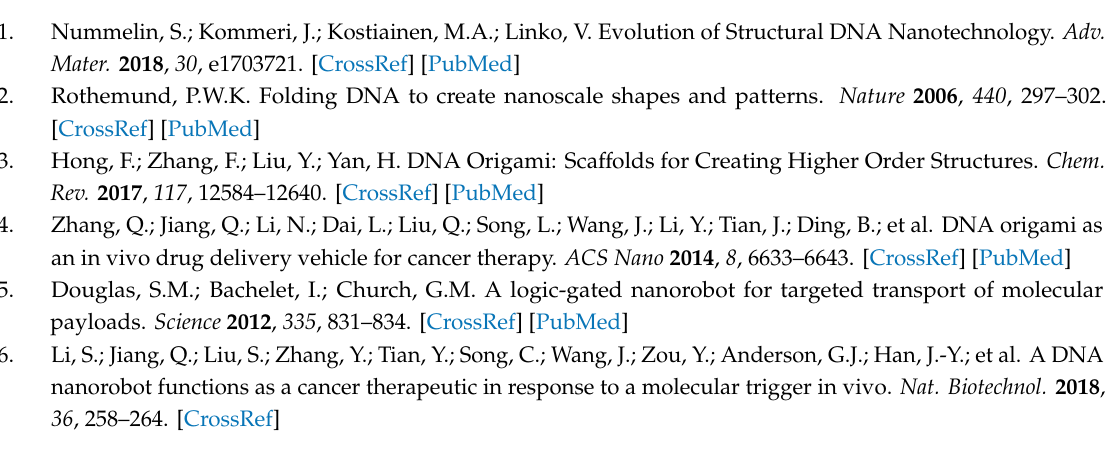
Supplementary Materials: The following are available online, Tables S1–S3: yields for the Rothemund triangles obtained from the evaluation of the individual AFM images recorded under liquid and dry conditions, Table S4–S6: p -values of the individual yields for the Rothemund triangles, Table S7: yields for the 6HBs obtained from the evaluation of the individual AFM images, Figures S1–S13: additional AFM